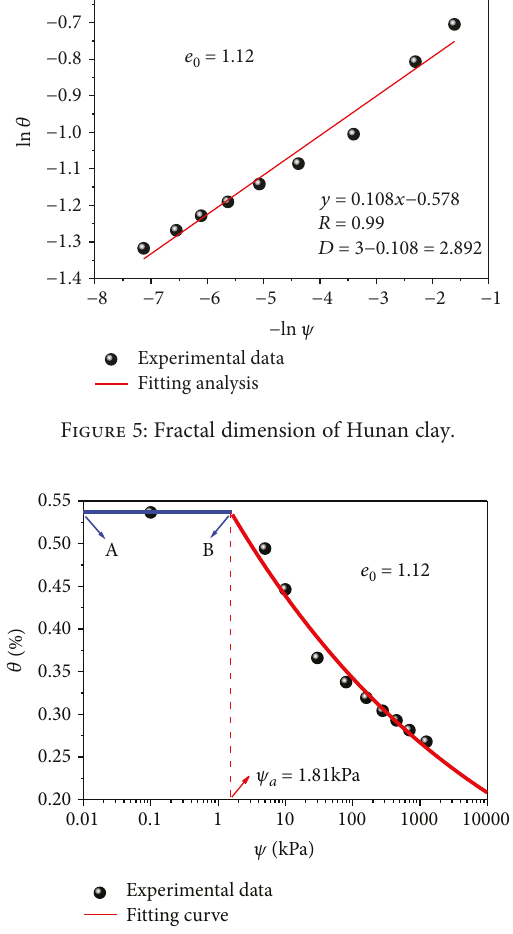
Figure 6: SWCC fi tting to get the air-entry value at a reference state ( e 0 = 1 12 ). Table 2: Predicted and experimental result of air-entry